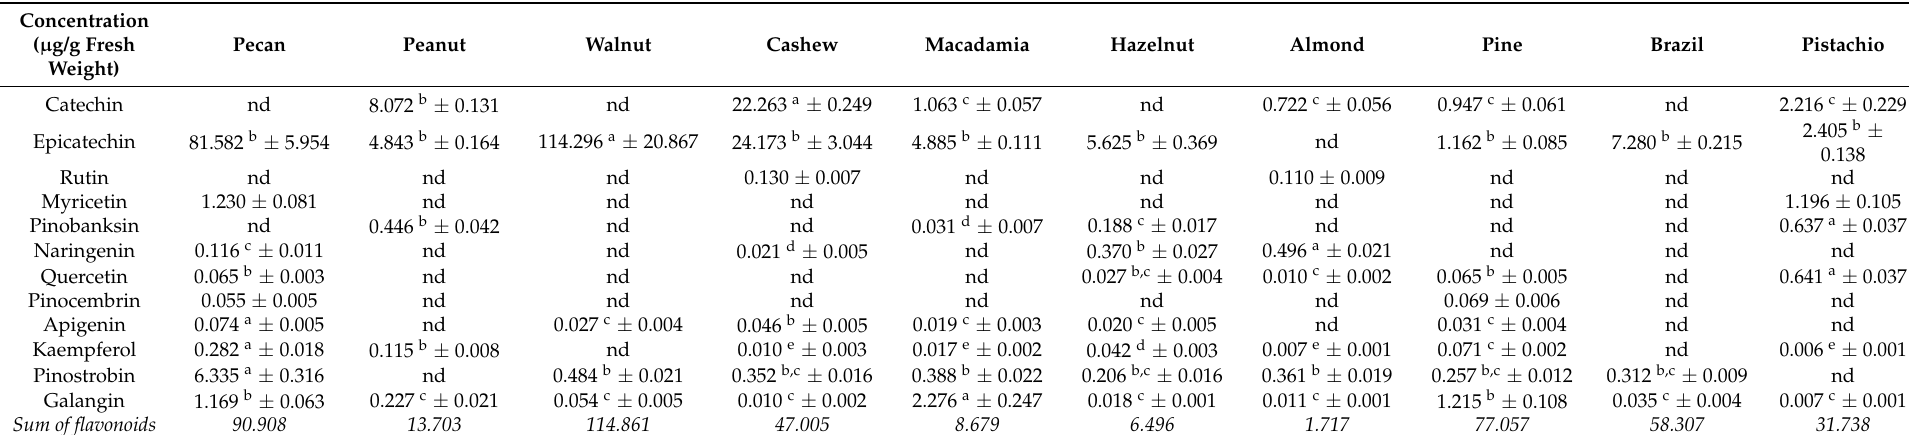
Table 1. The concentration of flavonoids in nuts.